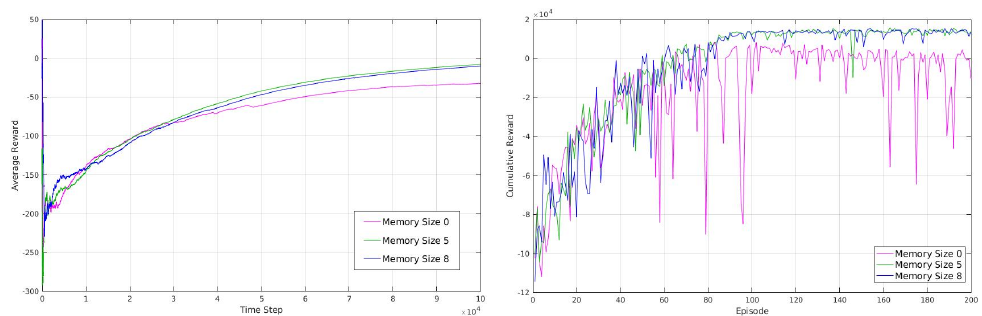
Figure 7. The ( left ) graph shows the average reward that robot obtains using Deep Q-Learning (discrete-action) over time (showing that robot is able to maximize its average reward). The ( right ) graph shows the cumulative reward that robot accumulate over time and in each episode, the graphs are drawn over (100,000 steps) using no short-term memory, short term memory of size 5 and short-term memory of size